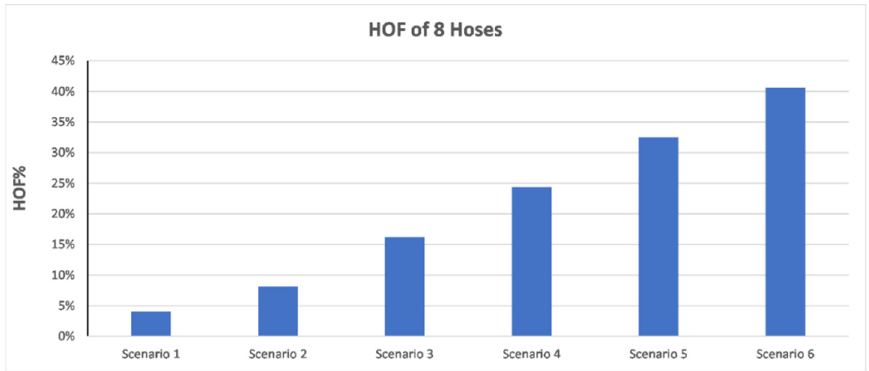
Figure 10. HOF indicator for 4 dispensers.